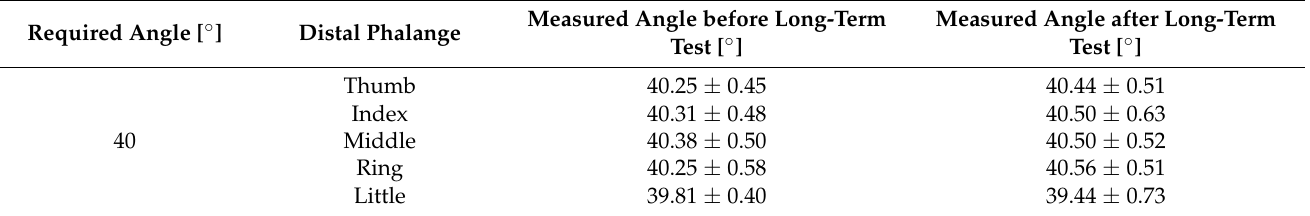
Table 3. Verification of distal phalange measured at an angle of 40 ◦ before and after the long-term test. Required Angle [ ◦ ]